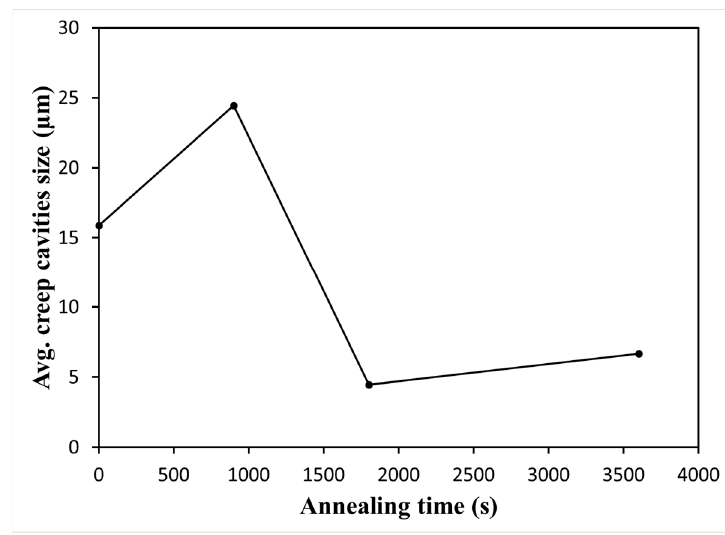
Figure 20. Effect of annealing time on the average creep cavity size